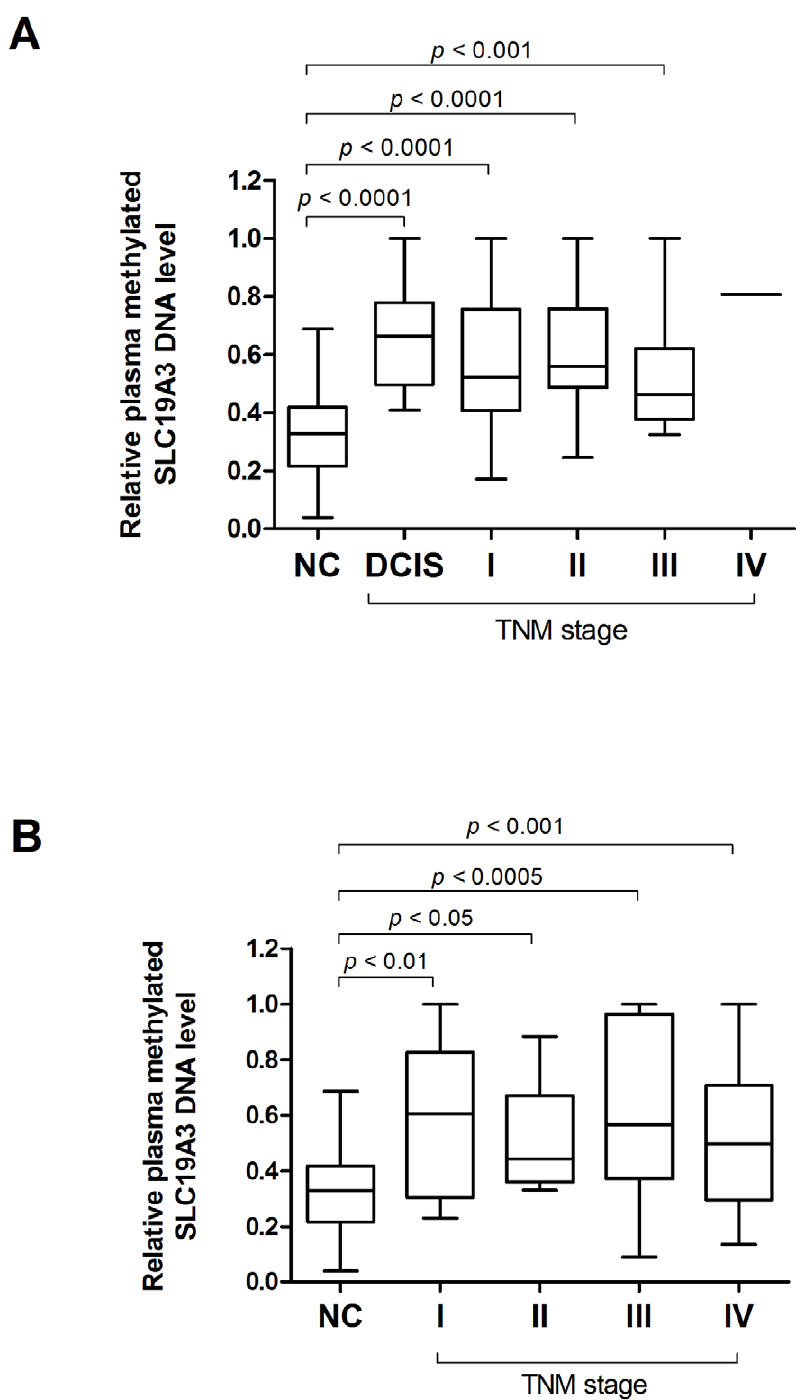
Figure 6. Plasma methylated SLC19A3 DNA levels across tumor stages from both Phase I and II validation. (A) Box plot of plasma methylated SLC19A3 DNA level in 80 NC, 27 ductal carcinoma in situ (DCIS) plus 71 BC patients across various TNM stages. (B) Box plot of plasma methylated SLC19A3 DNA level in 80 NC and 65 GC patients across various TNM stages. The box represents the interquartile range and the line across the box indicates the median value. Relative plasma level of methylated SLC19A3 DNA is expressed as 2 2 D Ct(Dig-Undig) . D Ct (Dig-Undig) is calculated by subtracting the Ct values of digested plasma DNA from the Ct values of undigested plasma DNA. Statistically significant differences were determined using Mann-Whitney tests.